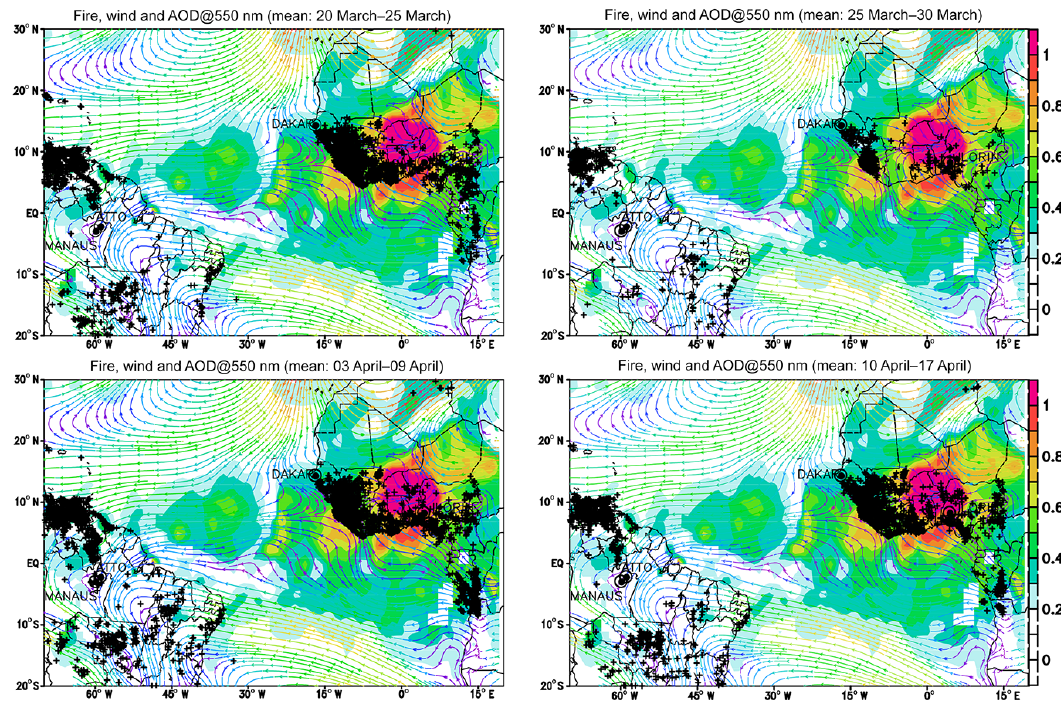
Figure 5. Mean aerosol optical depth at 550nm (AOD, shaded color) and wind at 850hPa (stream lines) and total fire spots (black plus symbol) for four distinct periods within the campaign at ATTO site, during the dominance of (a) the first Saharan dust outbreak; (b) a less active dust outbreak period; (c) the second Saharan dust outbreak; (d) the third Saharan dust outbreak.